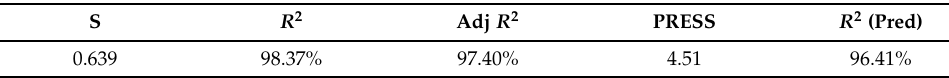
Table 3. Predictive ability and fit of Use restroom PLSR model.